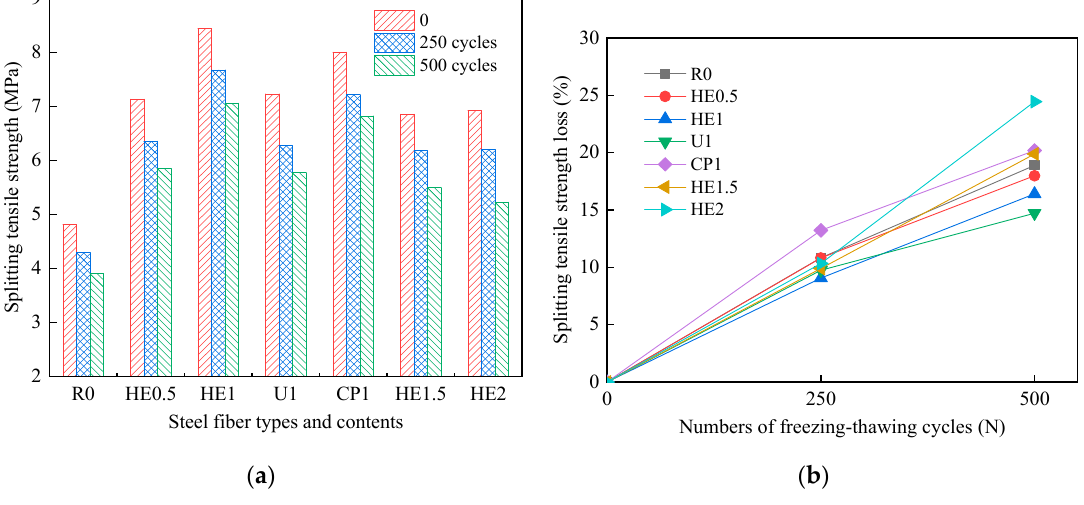
Figure 6. ( a ) Splitting tensile strength and ( b ) splitting tensile strength loss of CGAC with different types and content of steel fibers after F-T cycles.